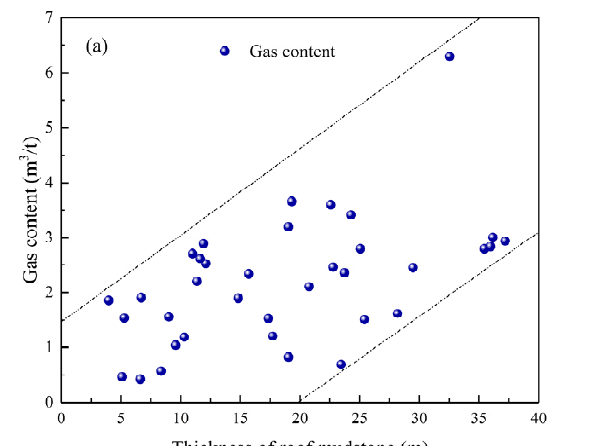
Figure 8. The relationship between gas production and gas content.